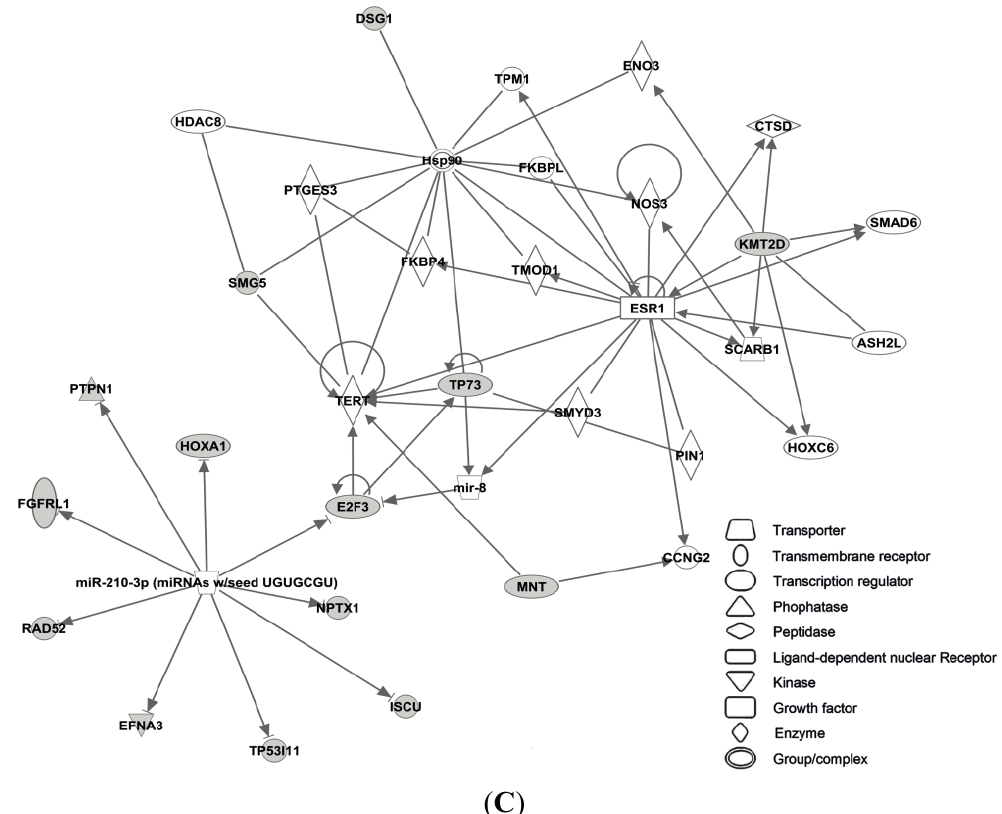
Figure 4. IPA networks for miR-26a, network 2 ( A ), miR-519a, network 1 ( B ) and miR-210, network 1 ( C ), centered on the estrogen receptor (ESR1). These networks created by IPA comprise networks with ER as a direct (miR-26a) or indirect (miR-519a and miR-210) target. Shaded boxes refer to direct targets whilst clear boxes refer to indirect targets of the specific